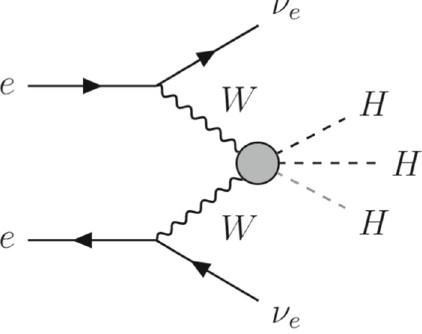
Fig. 5 Multiple Higgs production via